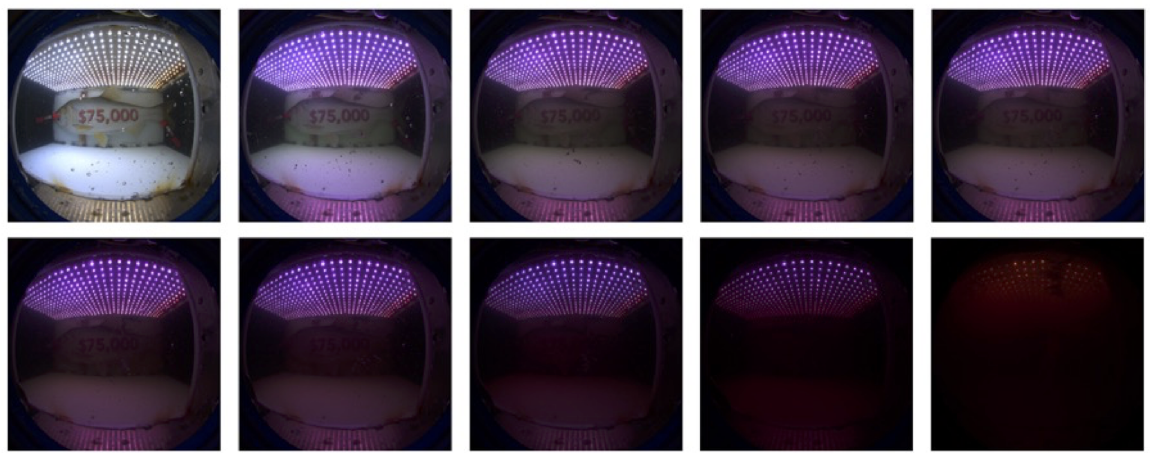
Figure 3. Water turbidity sample images with increasing turbidity from left to